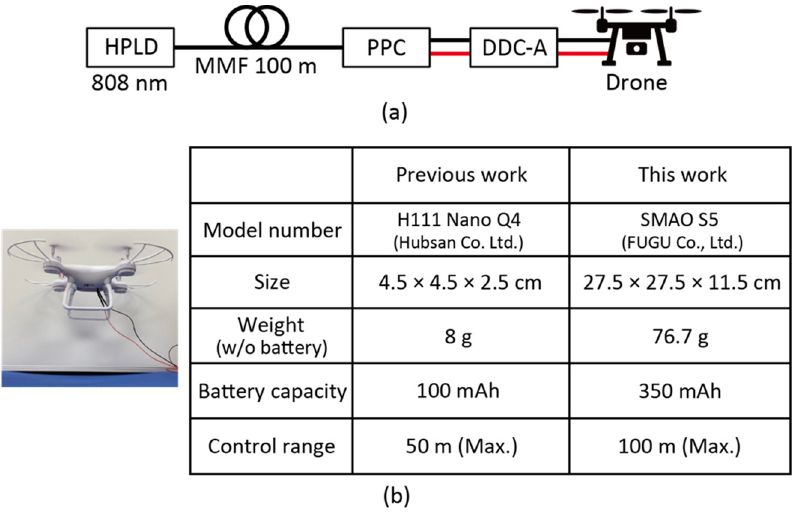
Figure 10. ( a ) Experimental setup for drone flight demonstration. ( b ) Photograph of drone flight demonstration and basic specification of drones used in a previous study and this